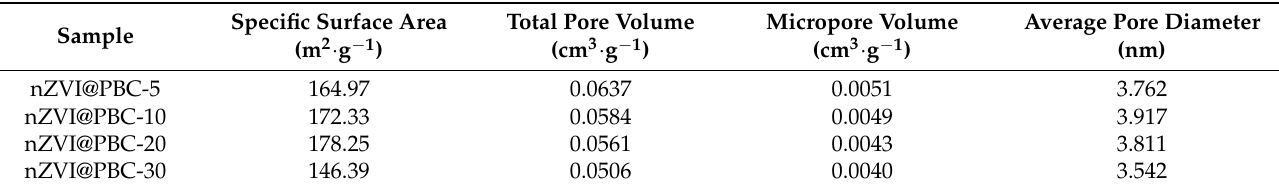
Table 1. Pore structure characteristics of